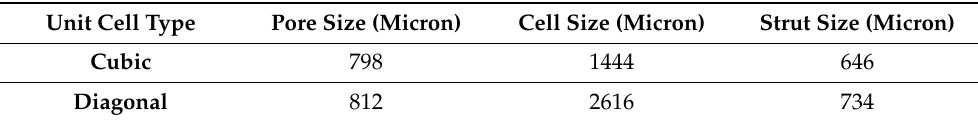
Table 2. Geometrical parameters of the optimized BTE scaffolds.